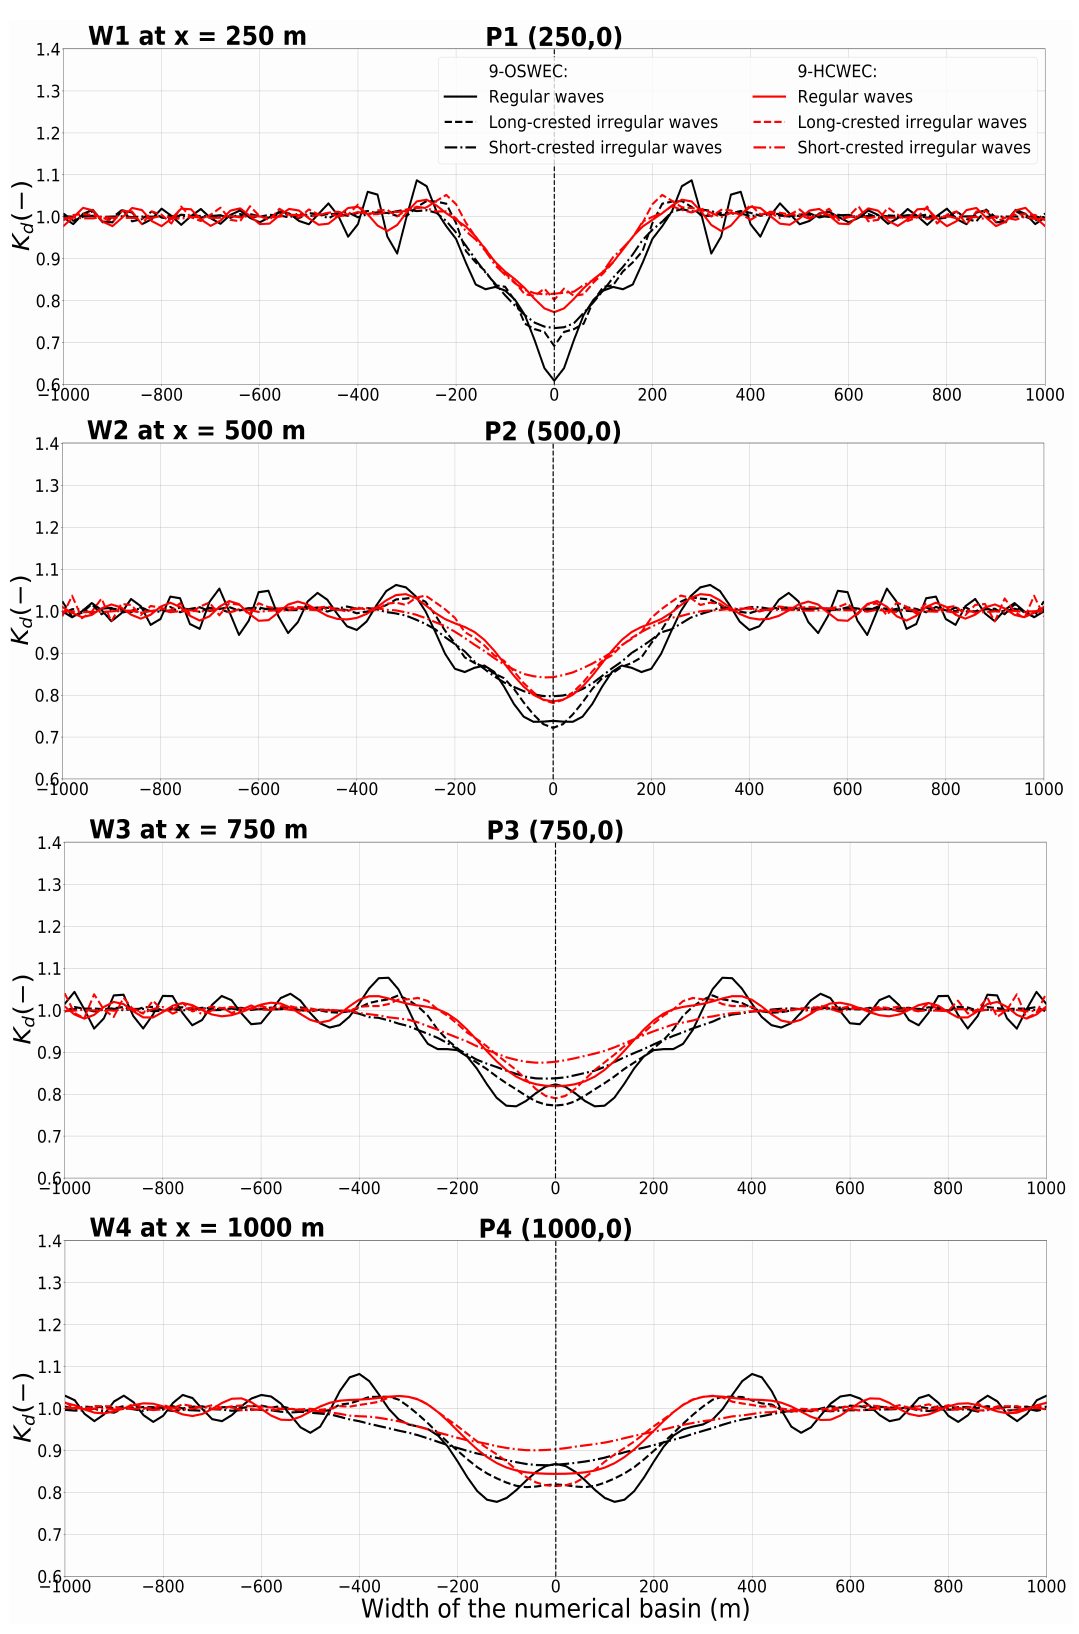
Figure 13. K d disturbance coefficient results along four transversal cross-sections W1, W2, W3 and W4 as indicated in Figures 9–11, for a 9-OSWEC (O2) and a 9-HCWEC (H2) array interacting with regular, irregular long-crested, and irregular short-crested waves,